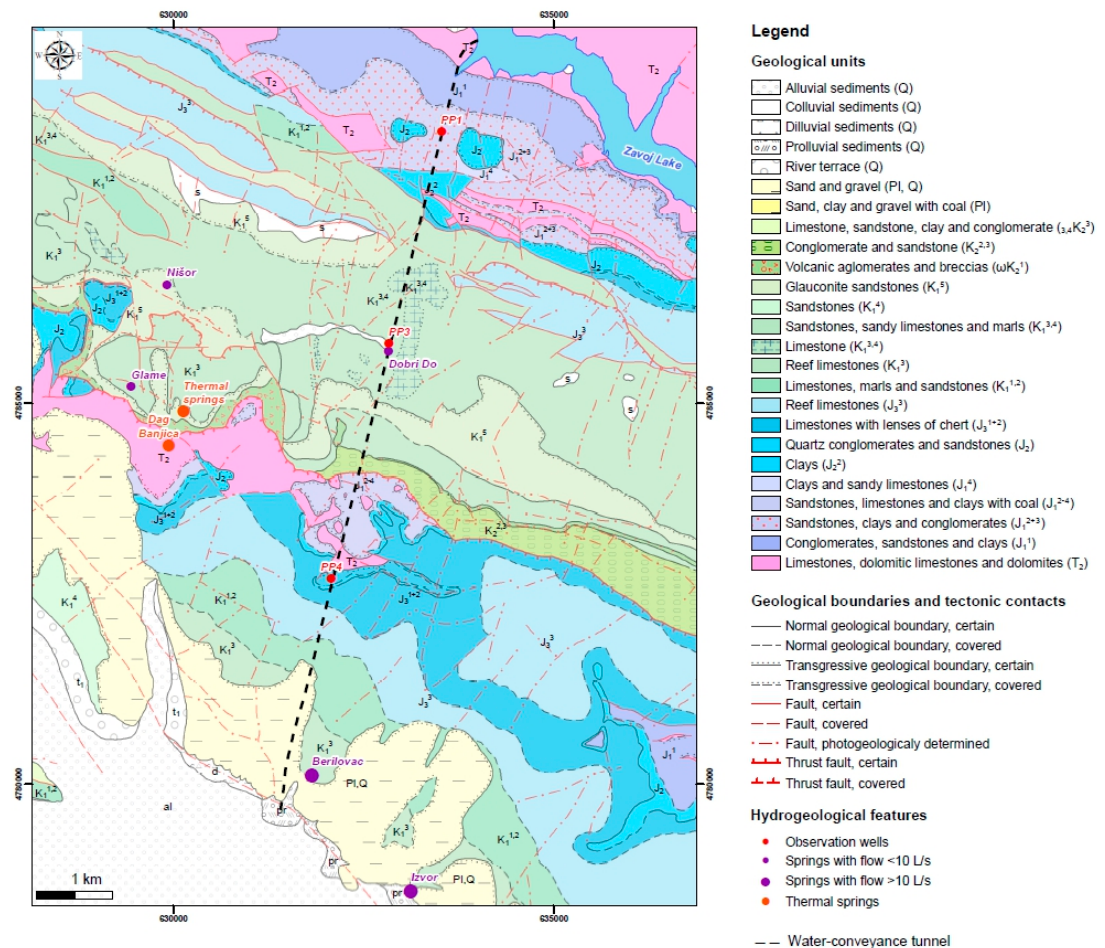
Figure 2. Geological map of the study area.